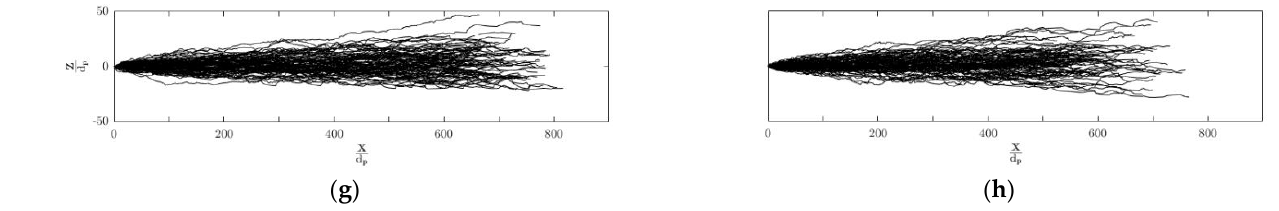
Figure 3. Top view (X-Z axes) sample of particles moving with different particle concentrations for 𝜏 ∗ 𝜏 ∗𝑐 ⁄ = 1.79: ( a ) 1000 particles; ( b ) 3000 particles; ( c ) 4500 particles; ( d ) 6500 particles; ( e ) 13,000 particles; ( f ) 26,000 particles; ( g ) 52,000 particles; and ( h ) 99,000 particles.